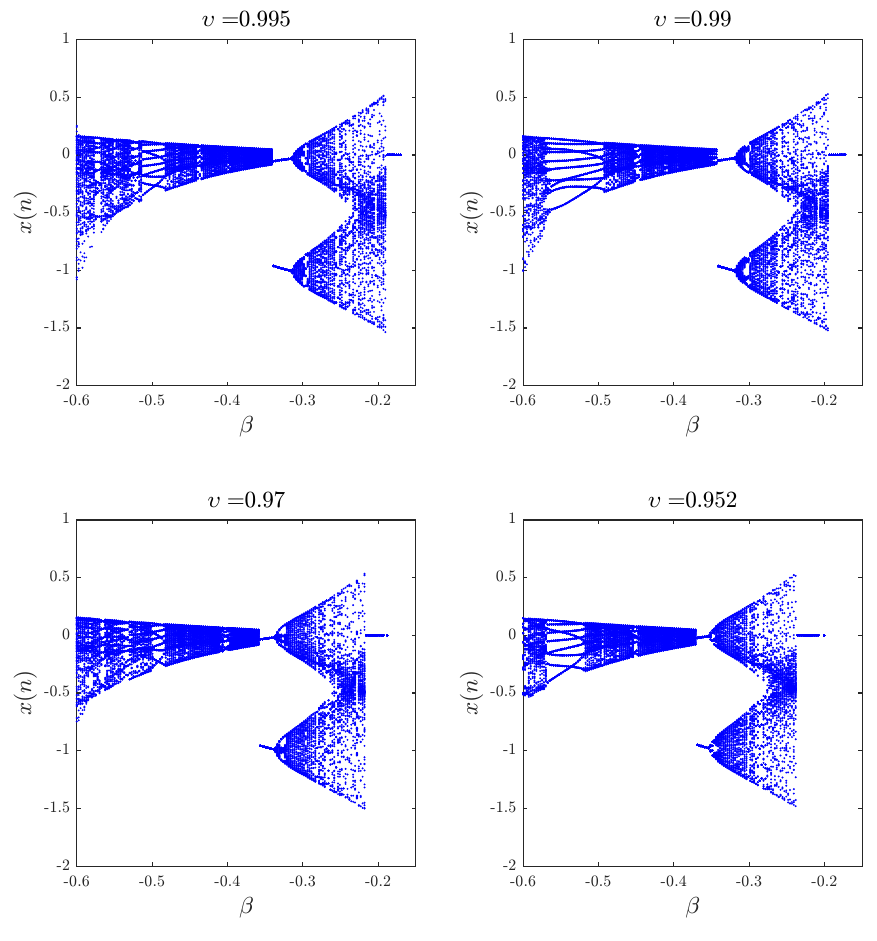
Figure 4. Bifurcation diagrams of the fractional Tinkerbell map (7) with β ∈ [ − 0.6, − 0.1 ] being changed in steps of ∆ β = 0.0025, parameters ( α , γ , δ ) = ( 0.9,2,0.5 ) , initial conditions ( x ( 0 ) , y ( 0 )) = ( − 0.72, − 0.64 ) , and different fractional